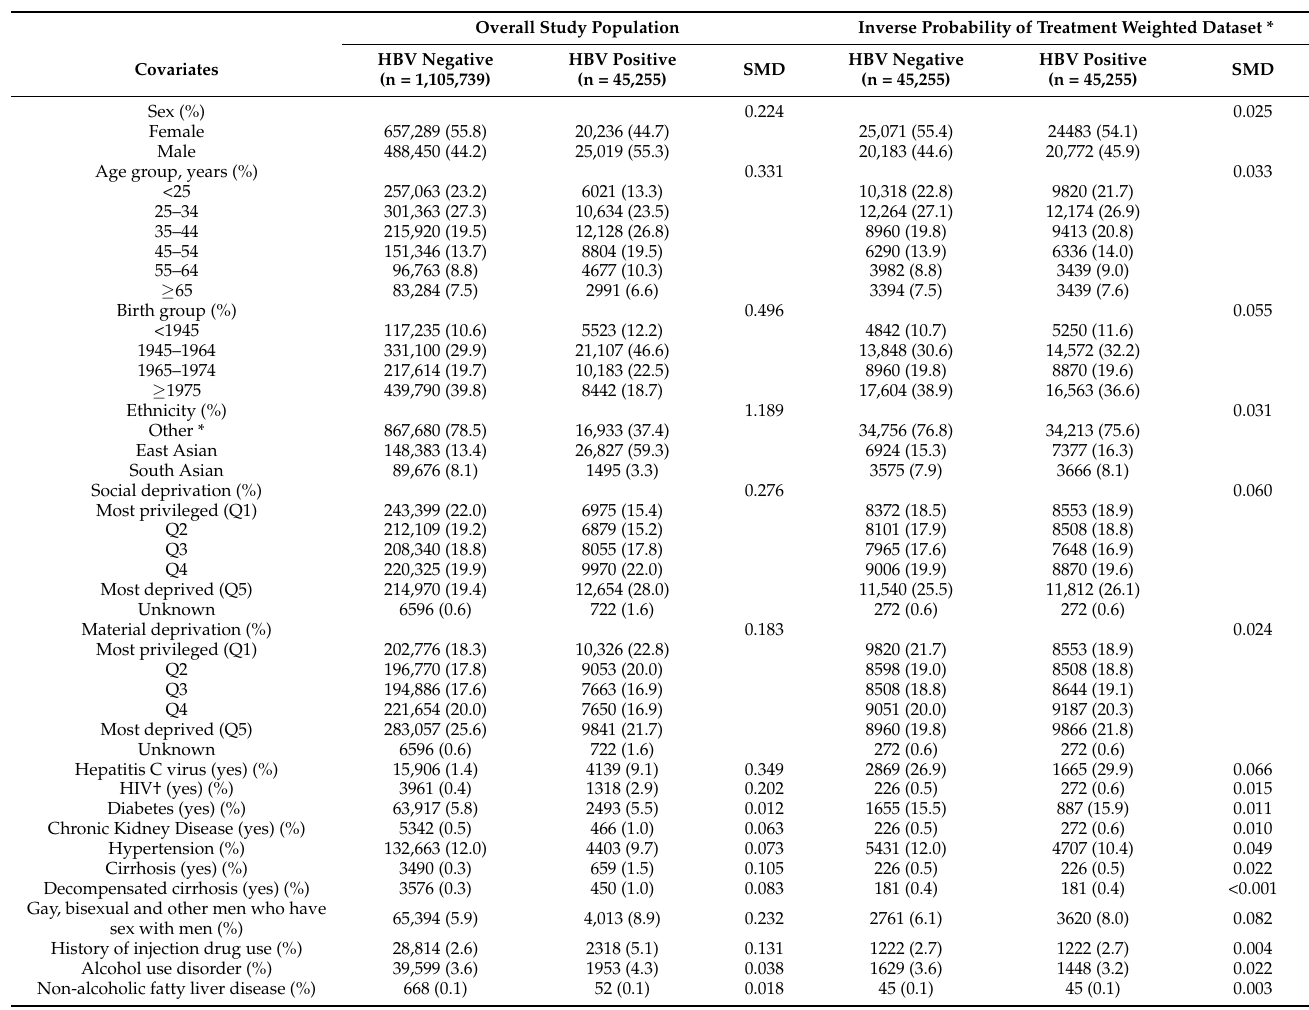
Table 1. Baseline study participants’ characteristics at the first HBV testing by HBV infection status and the propensity score (PS)-weighting dataset from the British Columbia Hepatitis Testers Cohort